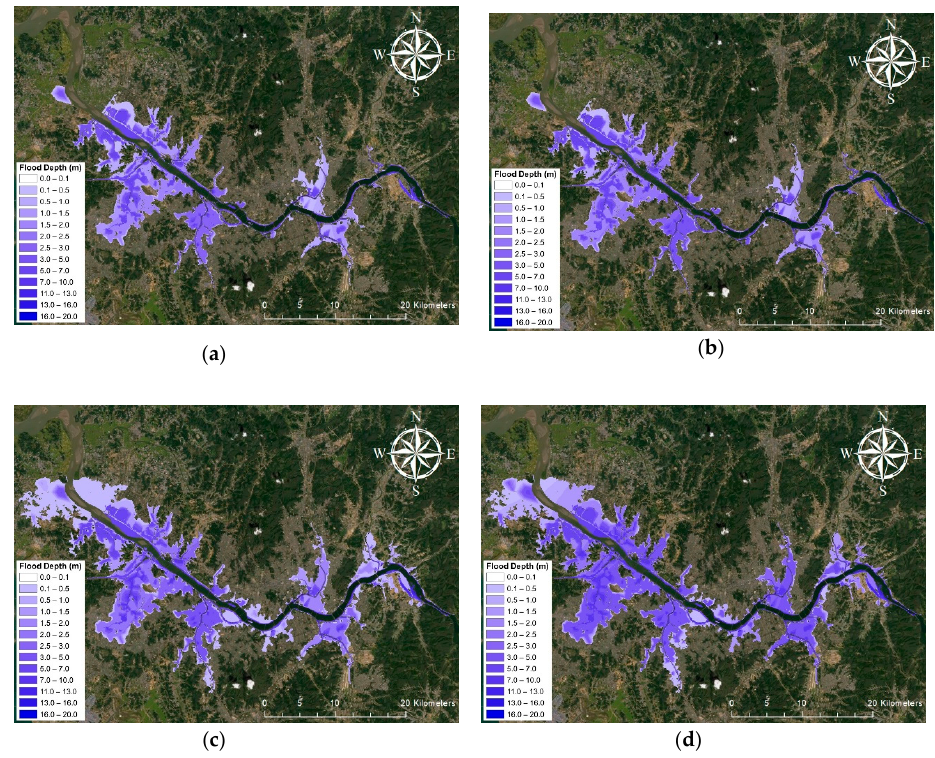
Figure 11. Flood Mmaps predicted by random forest regression. ( a ) 400 y; ( b ) 600 y; ( c ) 1000 y; ( d ) 2000 y.